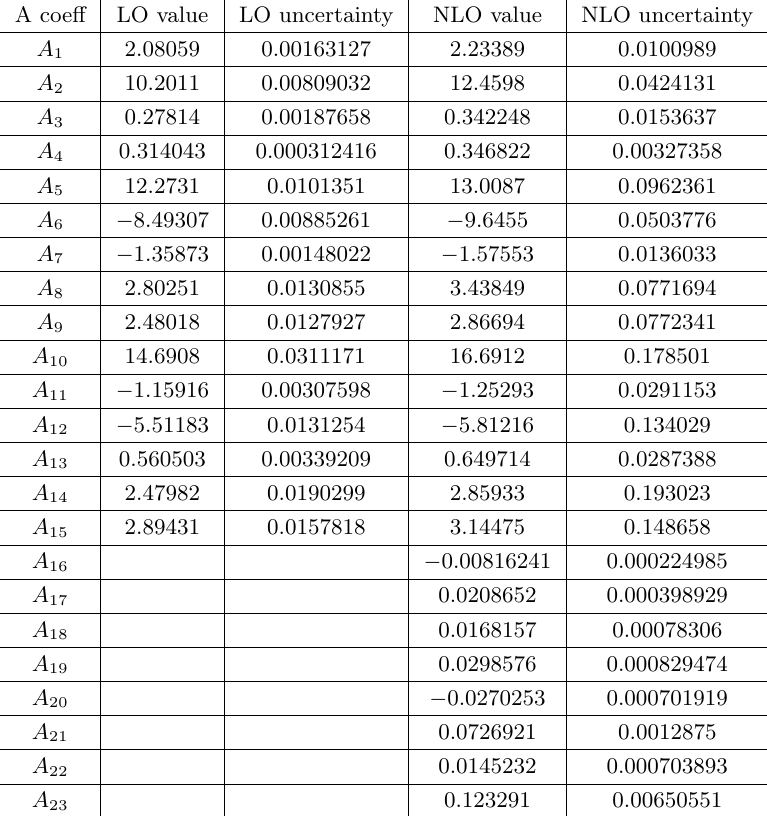
Table 1. Results for the coe(cid:14)cients de(cid:12)ned in eq. (3.1). The uncertainties are obtained from the uncertainties on the total cross sections entering the projections, using error propagation which neglects correlations between these cross sections.